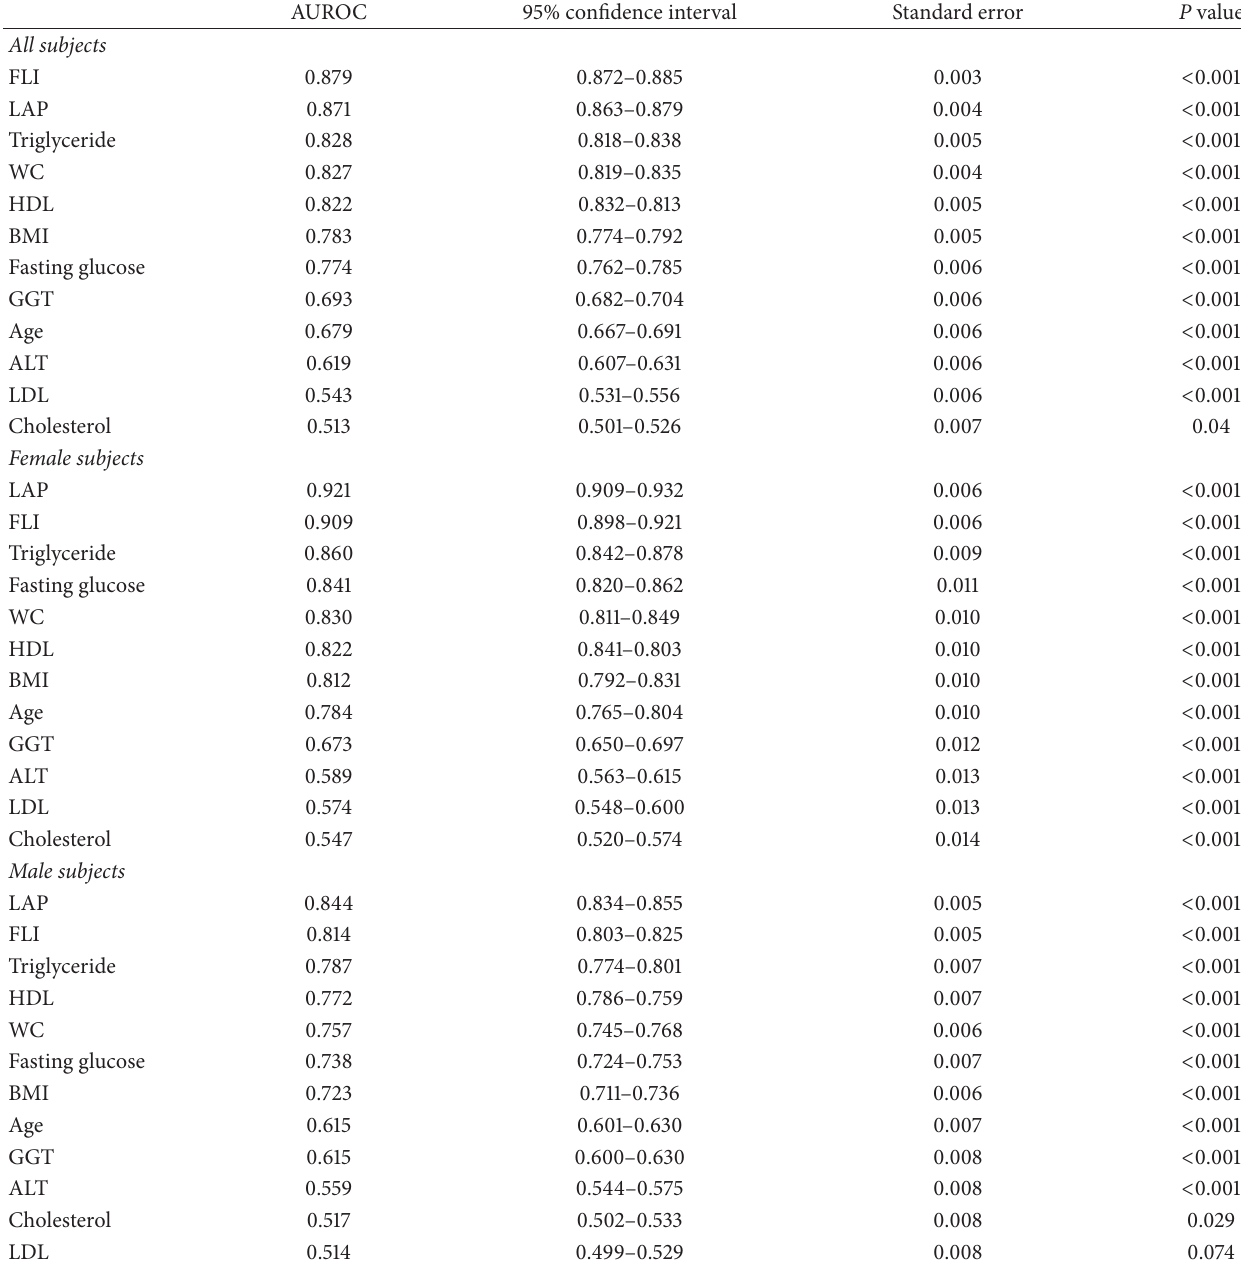
Table 8: Comparison of AUROC curve values among non-fatty liver subjects with metabolic